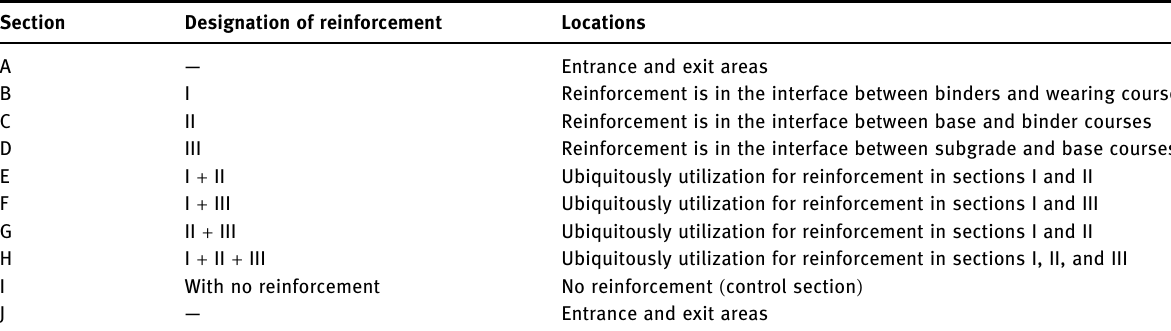
Table 6: Model sections reinforcement designation